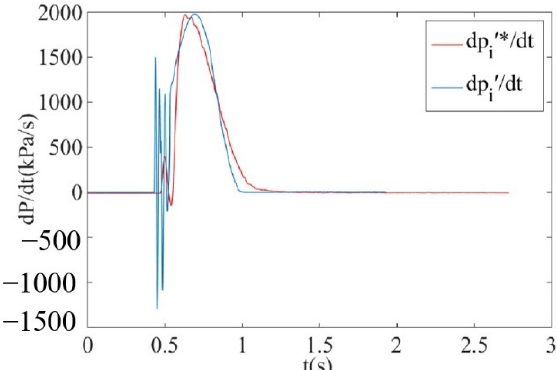
Figure 20. Measurement curve of the brake pressure change rate under simulation analysis and measurement test.